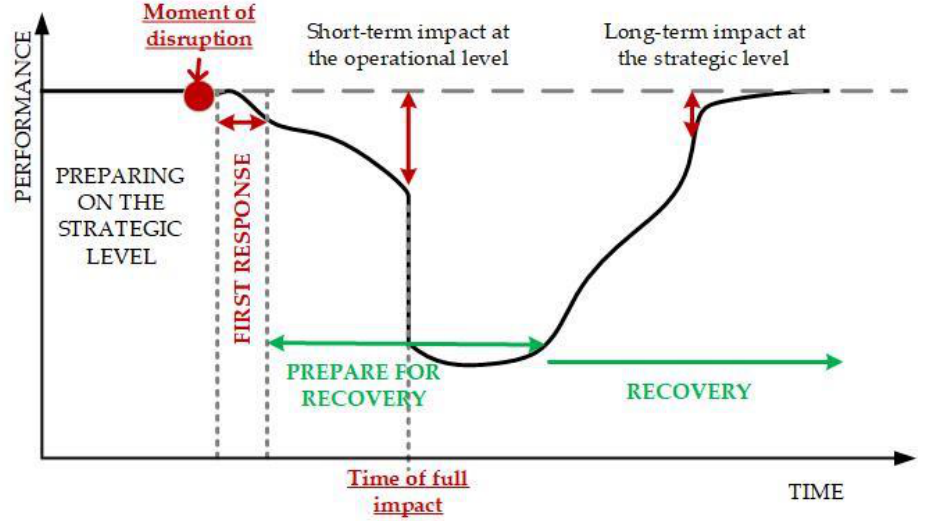
Figure 1. The phases of the disturbance occurrence and the system reaction at the operational and strategic level (based on [11]).